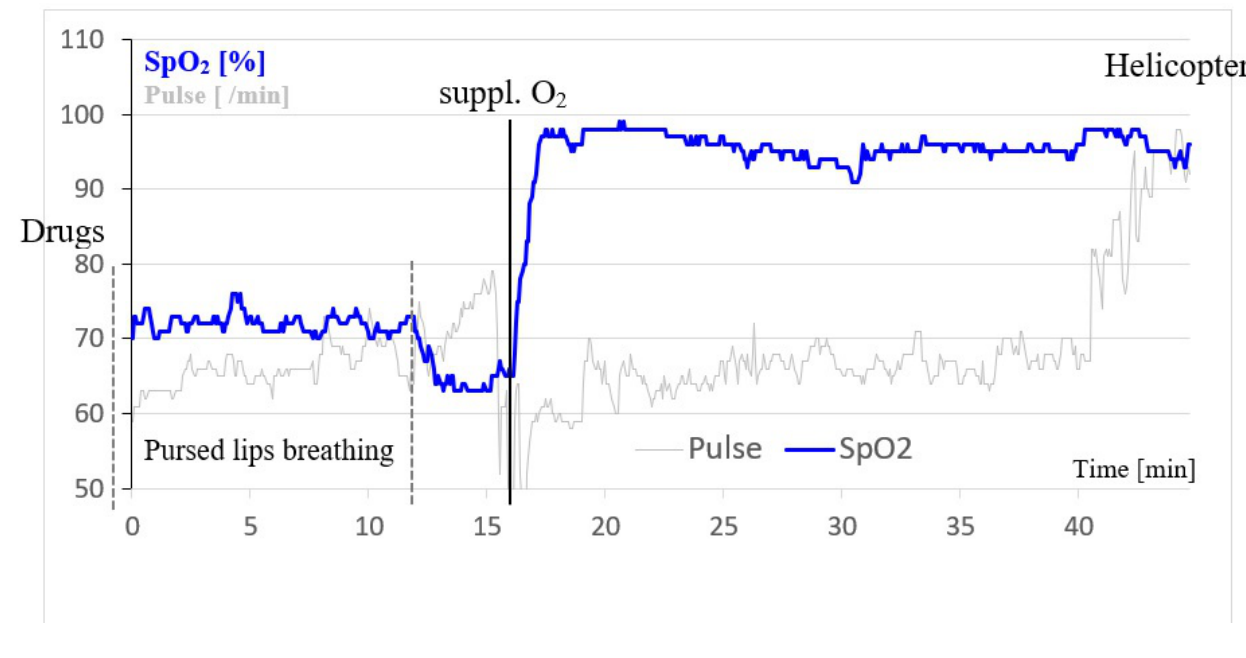
Figure 1. Time course of peripheral oxygen saturation (SpO 2 ; blue) and pulse (grey) in O 2 -Pat at 4870 m. The black line indicates the start of supplemental oxygen at an initial flow rate of 3.0 L/min which was reduced to 0.5–1.0 L/min after several minutes. The grey dotted lines show the attempt of pursed lips breathing that had to be stopped after 12 min because of exhaustion. Drugs: administration of 8 mg of Dexamethasone, 20 mg of Nifedipine retard, and 800 mg of Ibuprofen. After 40 min O 2 -Pat walked to the helicopter (increasing pulse) using supplemental oxygen.